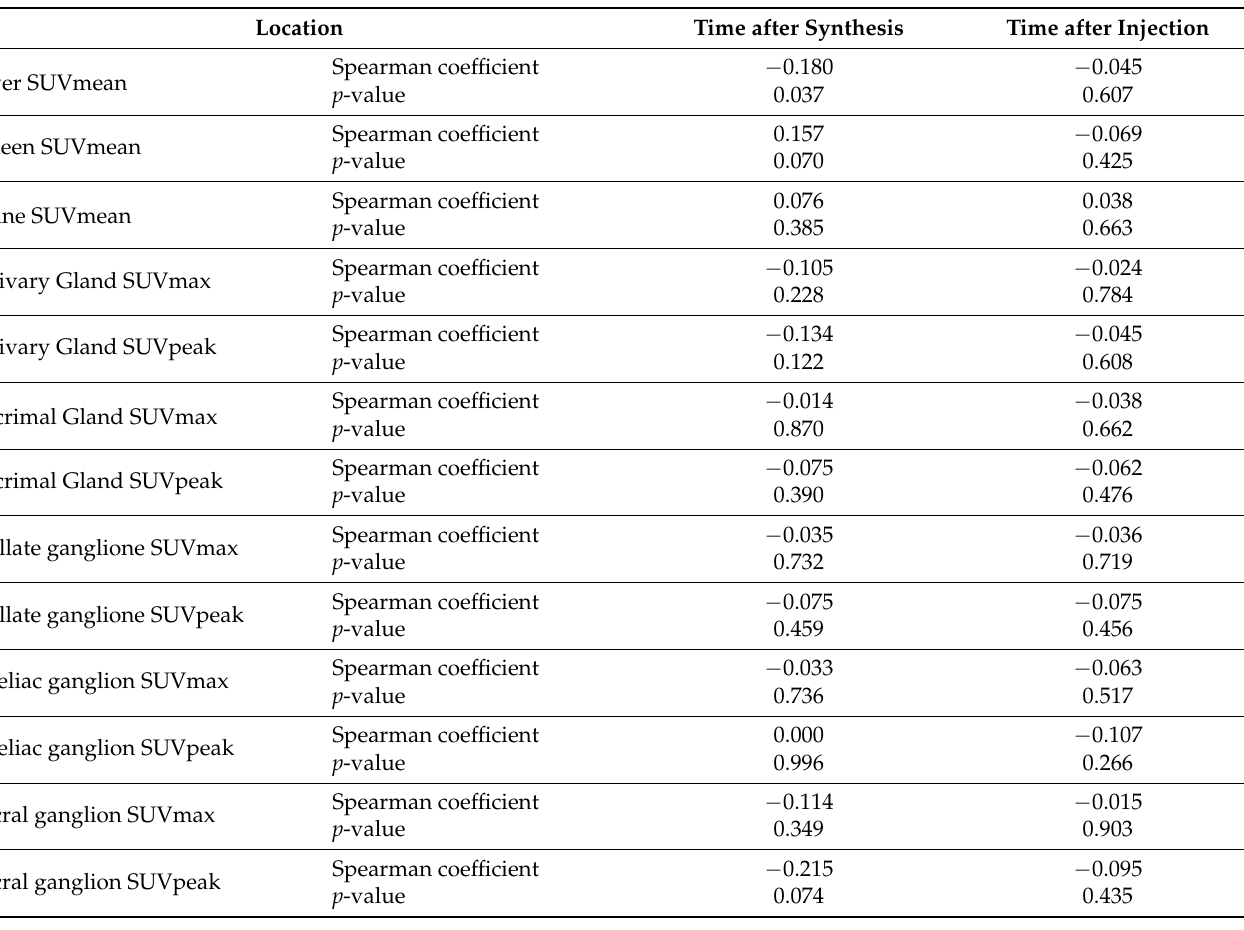
Table 3. Correlation of quantitative PSMA-PET parameters of different organs with known elevated physiological uptake and time after synthesis/time after injection.